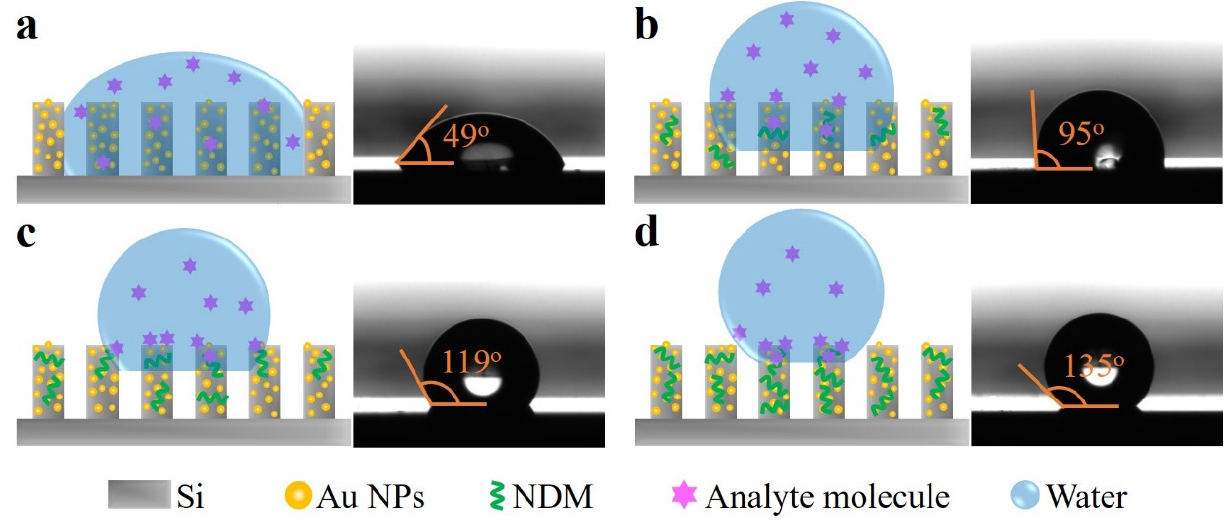
Figure 5. Schematic illustration of droplet contact behaviors on the SERS substrates soaked in NDM solution with different time and contact angles: ( a ) 0 s, ( b ) 60 s, ( c ) 300 s and ( d ) 900 s.